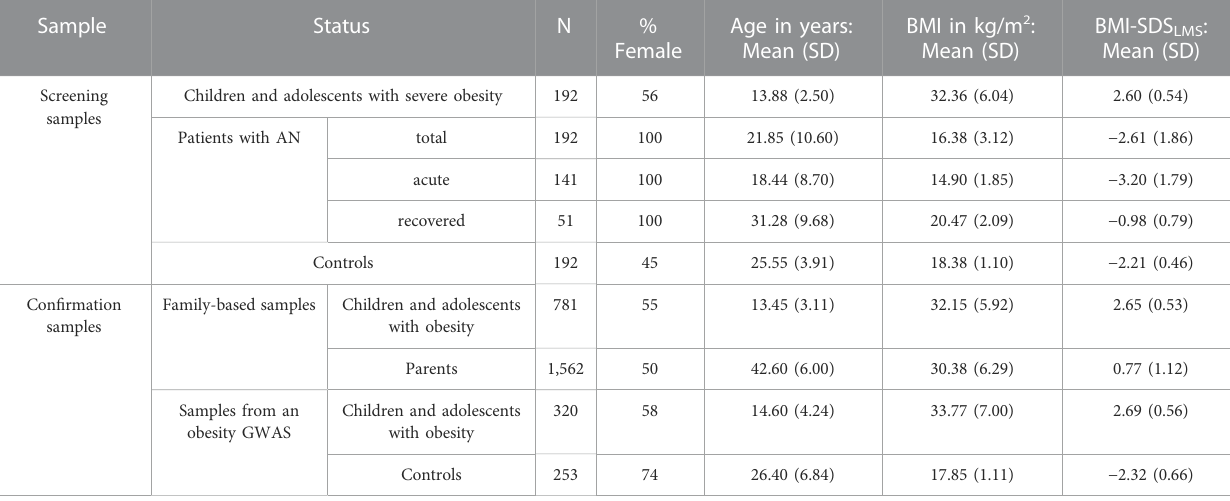
TABLE2Phenotypicdataofthescreeningandcon fi rmationstudygroups.Theinitialscreeningsamplessubjectedtothemutationscreenconsistedof192children andadolescentswithsevereobesityorAN(acuteorrecovered)and192healthy-leancontrols(Hinneyetal.,2007;Scheragetal.,2010;Boraskaetal.,2012;Watson et al., 2019). Additional genotyping was performed in an independent con fi rmation study group based on family-based samples consisting of the child or adolescent with severe obesity andboth biologicalparents(trios)as well as additional individuals with severe obesity or normal weight previously recruited for a case-control GWAS for obesity (Hinney et al., 2007; Scherag et al., 2010). Phenotypic data regarding BMI and age were missing for 16 parents. n: number of samples. SD: standard deviation.